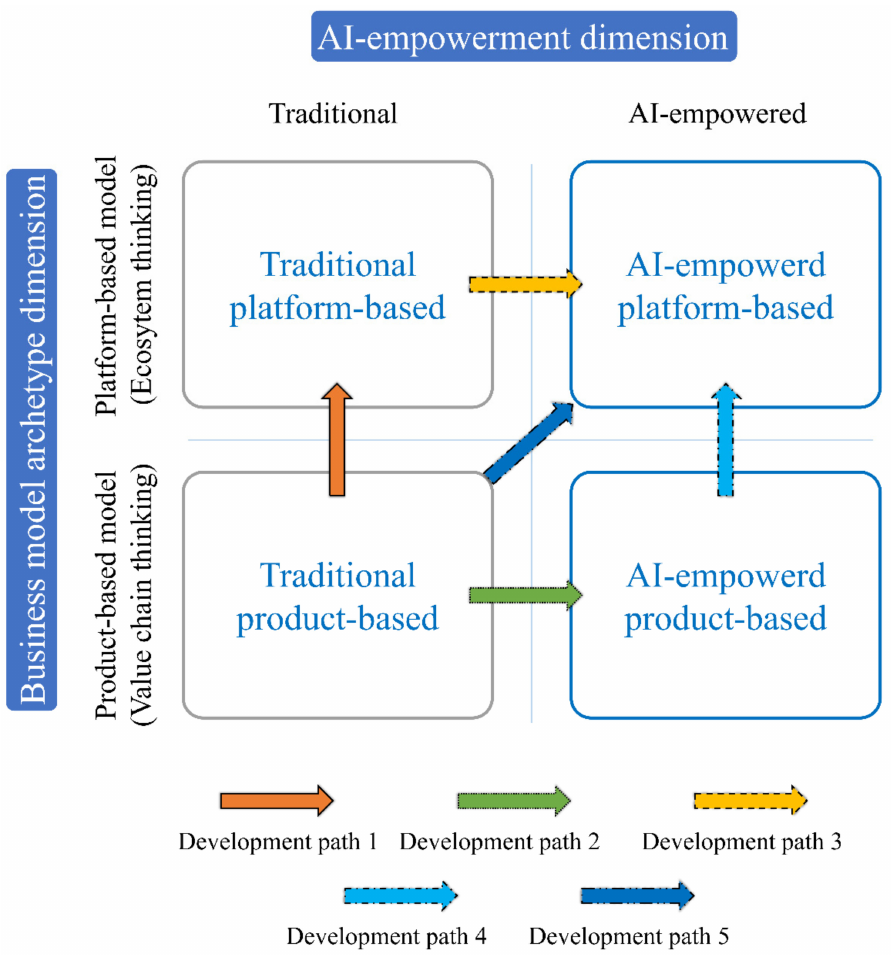
Figure 3. The AI (Artificial Intelligence) ecosystemic development path